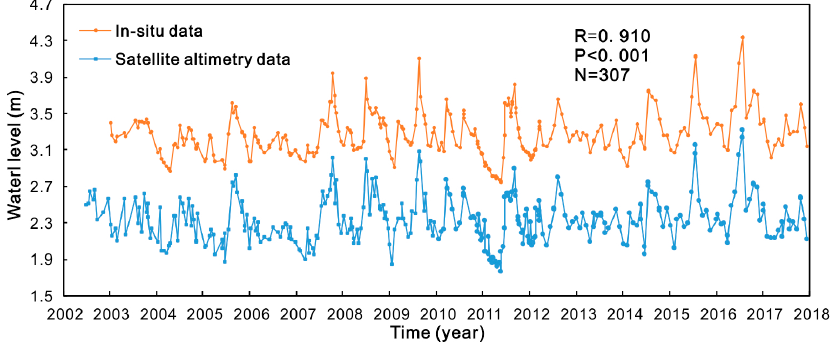
9 of 18 Figure 5. Correlation of Envisat, ICESat-1, Cryosat-2 measurements and the three combined measurements ( x -axis) with the in-situ lake level data ( y -axis) for ( a – d ) Tai Lake, ( e – h ) Chao Lake, and (i-l) South Dongting Lake, respectively. The correlation coefficient (R) and significant level ( P ) are also given. N is the number of observations.